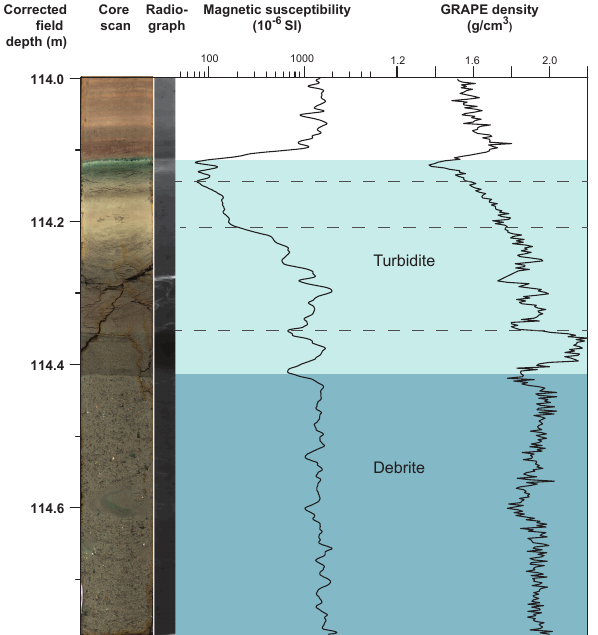
Fig. 5. A section of debrite D221 (age 2.43Ma) in a core scan from 5011-1A-38H-3. It consists of a basal debrite and a directly overlying debris-flow-induced turbidite. Both magnetic susceptibil- ity and density are high throughout the debrite. Density increases in the basal sand of the turbidite, while generally density values are the same or lower. Variation of magnetic susceptibility and density within the sandy and silty parts of the turbidite (114.25– 114.38mcfd) are caused by cracks in the core. Both parameters de- crease towards the clayey top. Intra-bed boundaries (dashed line) between subunits of the turbidite are marked by “steps” in magnetic susceptibility and density values.